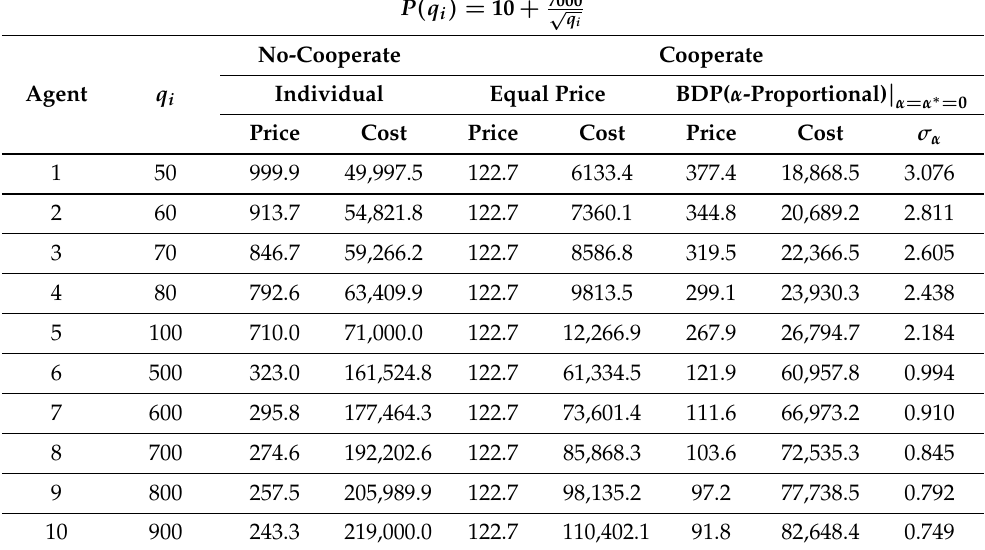
Table 2. Example 2 with α ∗ =